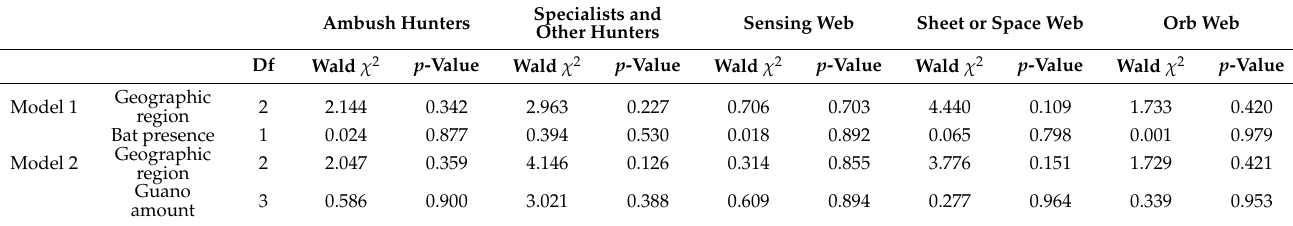
Table 2. GLM analyses of the effect of environmental variables on the probability to detect specific spider guilds in the caves. Wald χ 2 and p values are shown for the two models. Neither geographic region nor bat presence (or guano level) was a significant explanatory variable for any of the